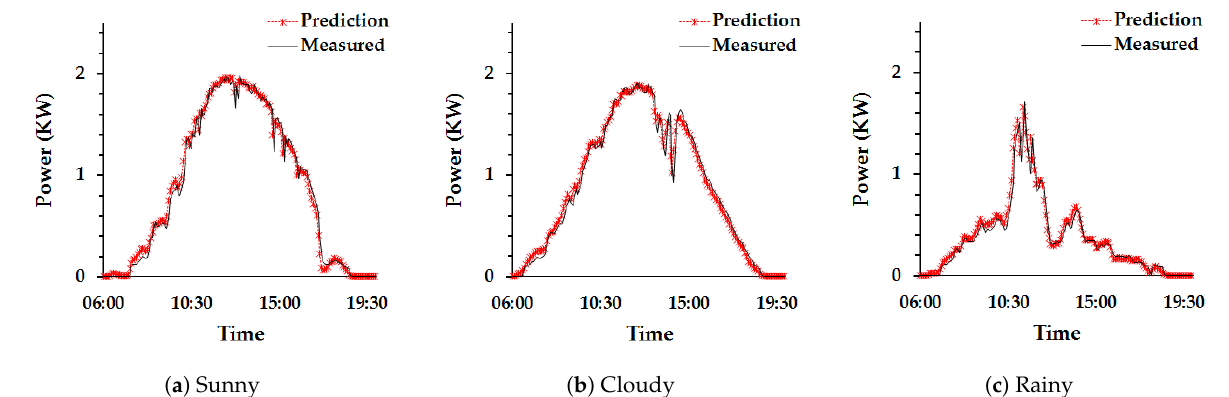
Figure 9. 5 min ahead very short-term forecast result of PV power generation (Layer = 3).